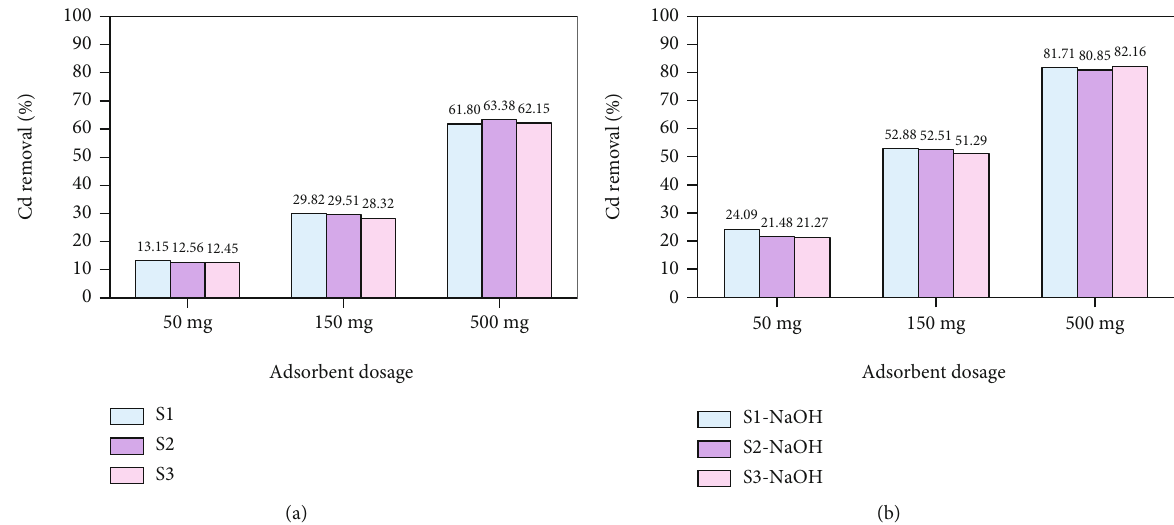
Figure 9: Adsorbent dosage e ff ect on Cd removal with rice husk (a) untreated and (b) treated ( pH = 7 , cadmiuminitialconcentration = 50mg/L , and rice husk size S1: < 212-425 μ m > , S2: < 425-600 μ m > , and S3: < 600-850 μ m > ).